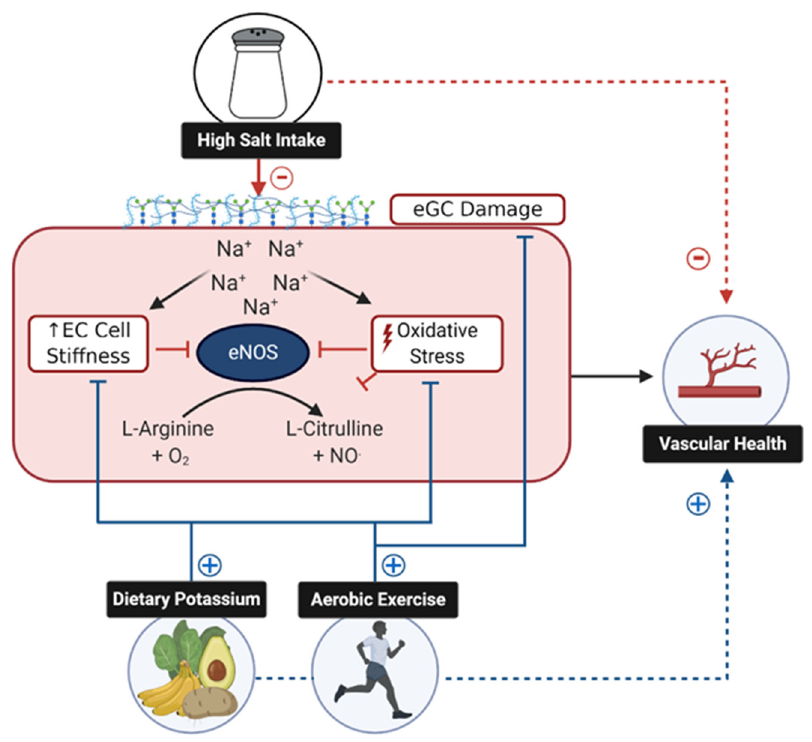
Figure 1. Excess dietary sodium negatively ( − ) influences nitric oxide (NO)-mediated endothelial function via increases in oxidative stress, an increase in endothelial cell (EC) stiffness, and damage to the endothelial glycocalyx (eGC). Each of these factors results in decreased bioavailability of NO derived from endothelial nitric oxide synthase (eNOS). Evidence suggests that aerobic exercise and/or increased intake of dietary potassium positively (+) influence these factors and thus may be effective strategies to counteract the impact of excess dietary sodium.